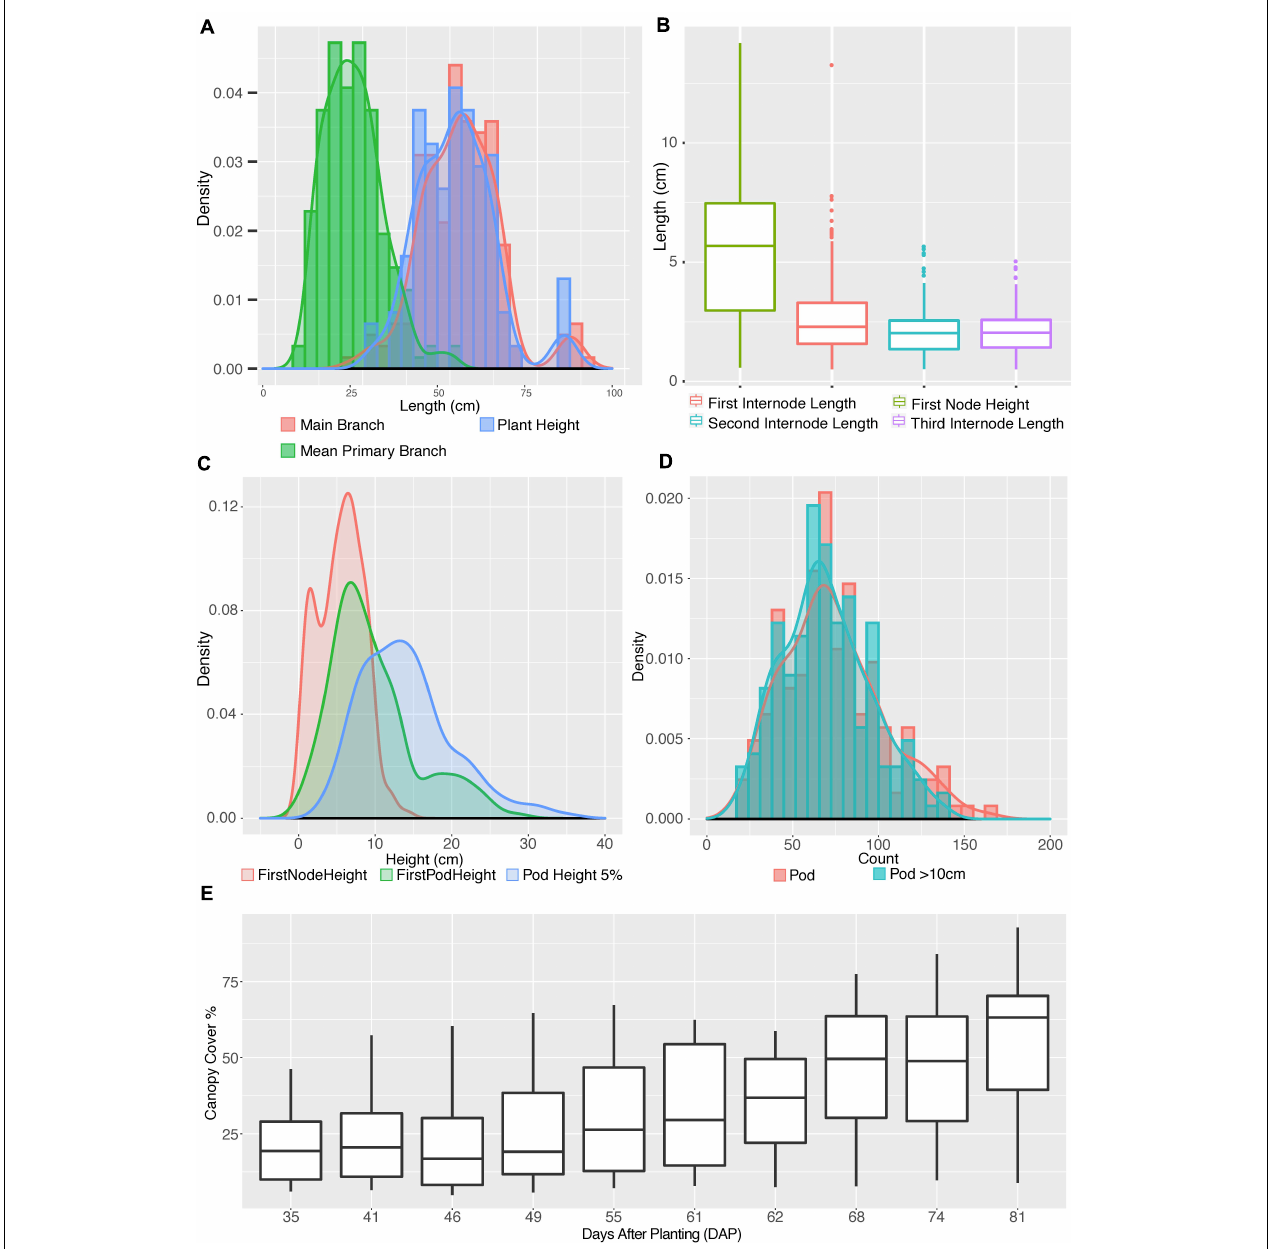
FIGURE 3 | Distribution of shoot architecture parameters in edamame plants. (A) Histograms and density plots for main branch length, plant height and average primary branch length. (B) Boxplot shows the distribution of first pod height, first, second and third internode lengths. (C) Density plots compare first node height with first pod height and 5% pod height. (D) Histograms and density plots for number of pods per plant and number of pods above 10 cm from ground. (E) Boxplot of canopy cover changes in the growth